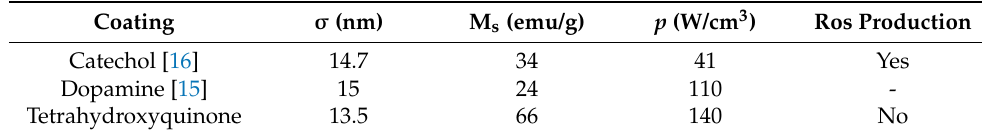
Table 3. The main physicochemical characteristics of IONPs coated with different phenol-derived compounds used in MHT.